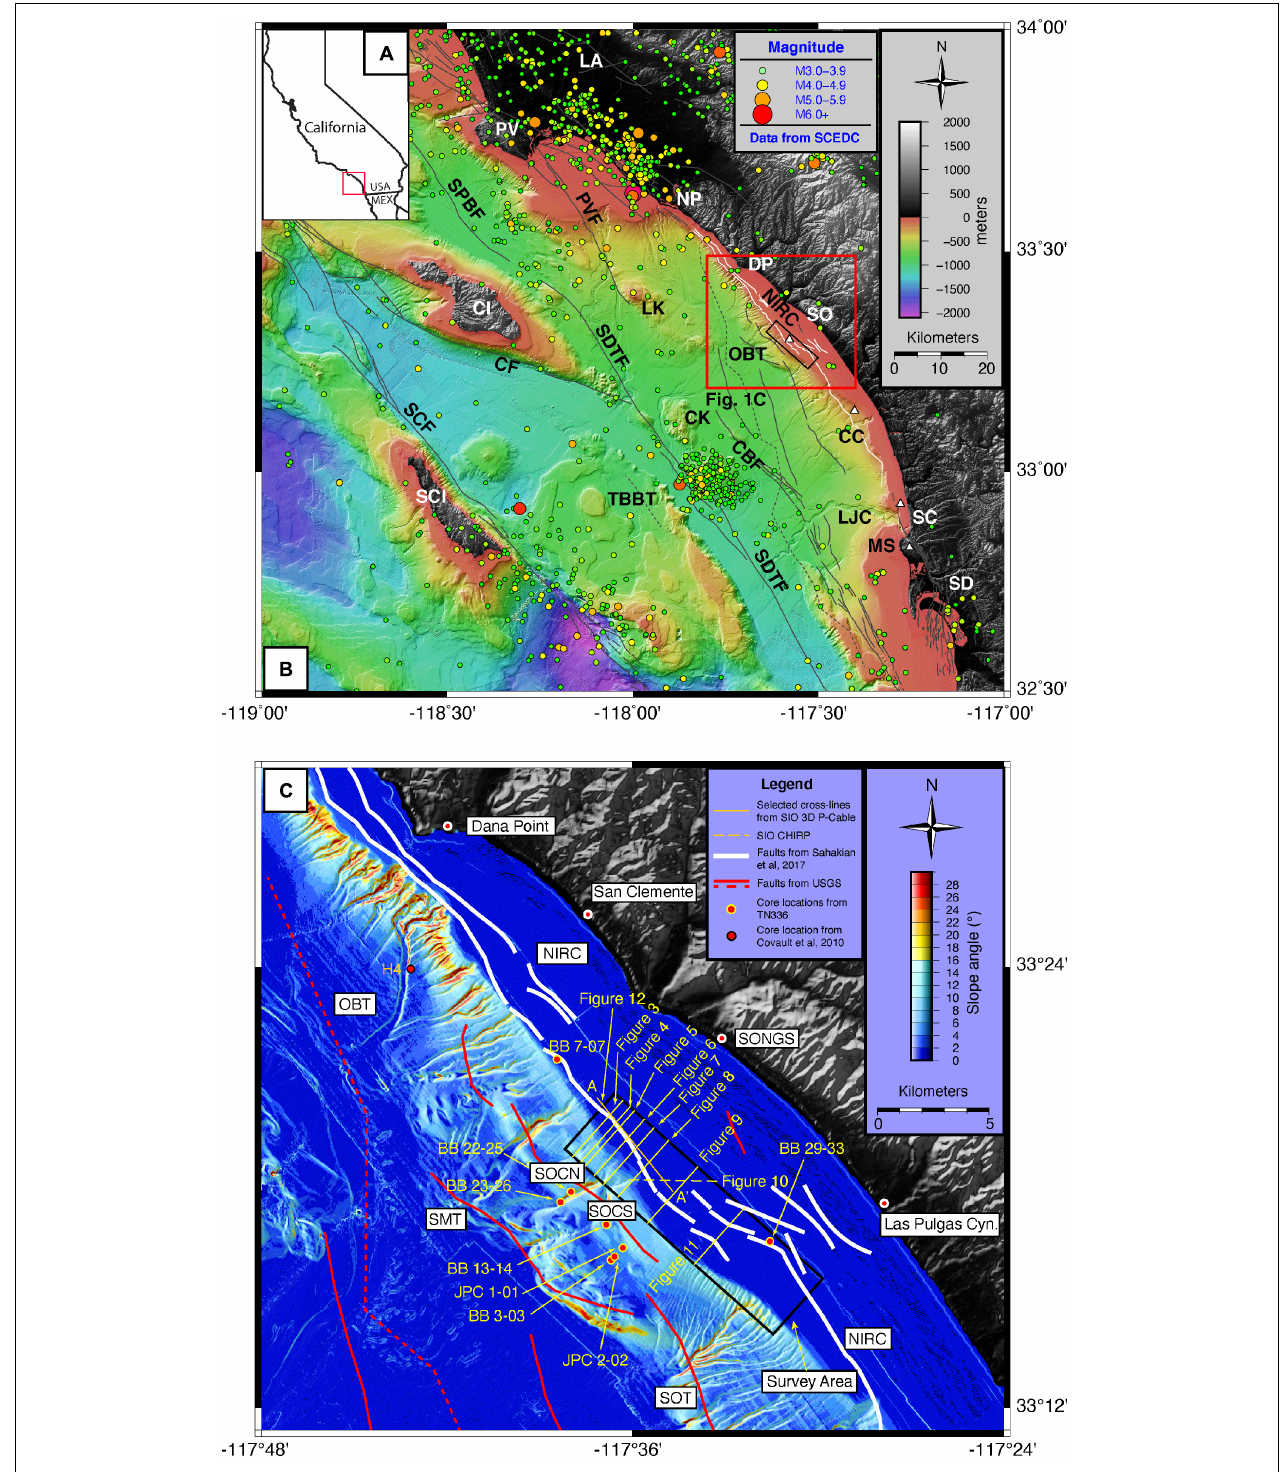
FIGURE 1 | (A) Regional map of California State showing the location of the Inner California Borderland – red box. (B) Area map of Inner California Borderland (ICB) relative to the southern California coast with historical seismicity data represented by colored circles. Seismicity data are from the Southern California Earthquake Data Center (SCEDC). Major fault systems are traced in solid black, with the exception of the Newport-Inglewood Rose Canyon (NIRC) fault system, traced in solid white. Red box outlines area shown in (C) . Black rectangle outlines the survey area. Scale for topography and bathymetry is shown. Dashed faults denote possible blind thrusts. White triangles denote approximate location of “pop-up” compressional structures due to leftward stepping of the fault strands. Major fault